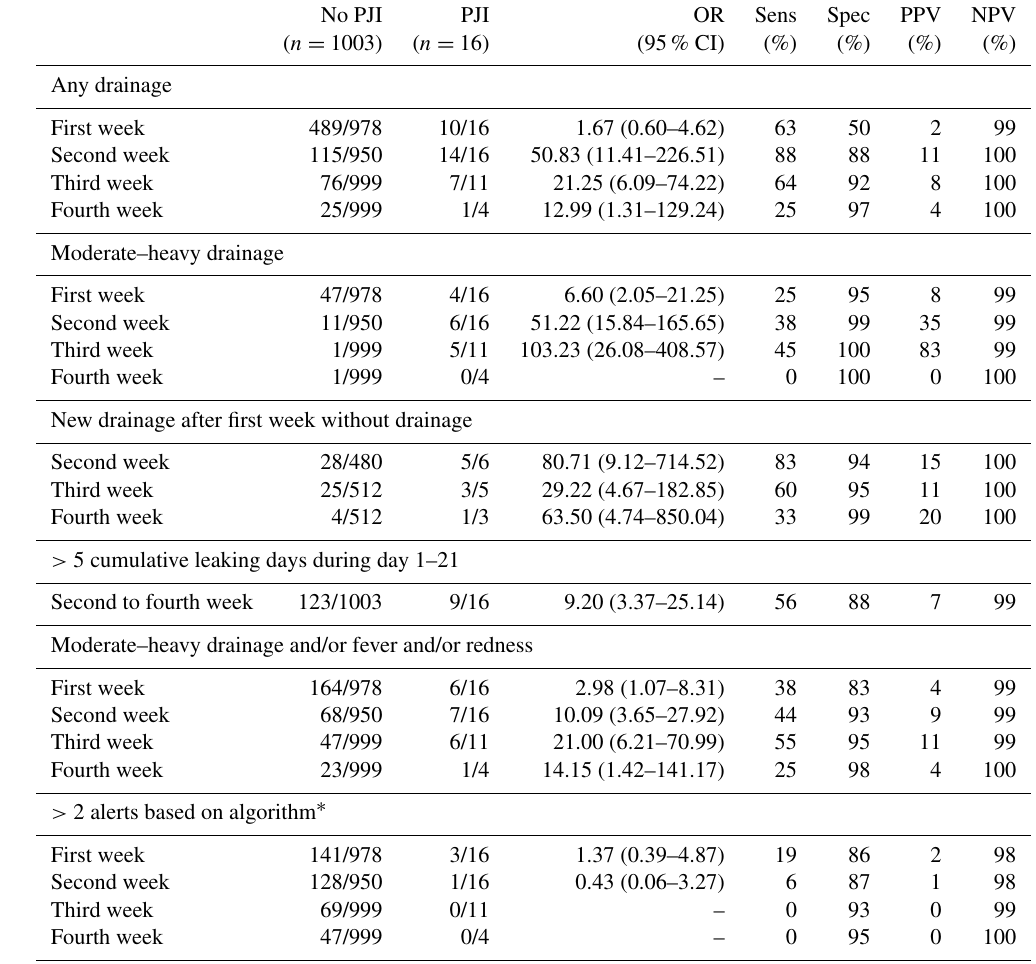
Table 6. Comparison of risk factors for failure in patients with and without